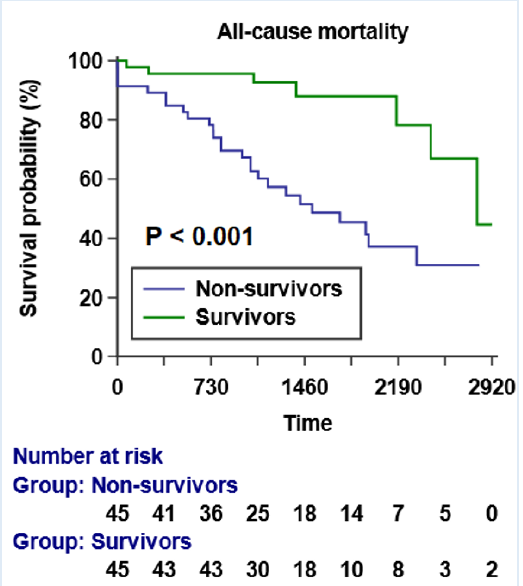
Conclusion: In this study, right ventricular strain as well as combined left and right ventricular strain was associated with all-cause mortality post- TAVI, while LV GLS and LVEF were